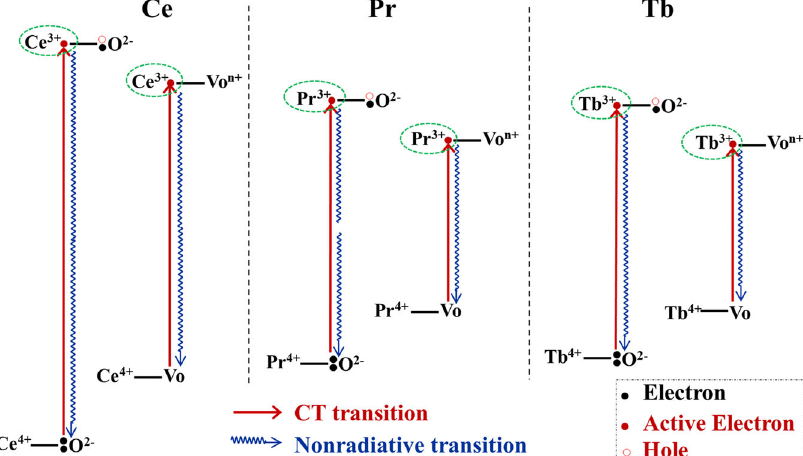
Fig. 8 The schematic diagram of charge transfer transition for Ce 4 + , Tb 4 + , and Pr 4 + . The hole in O2 p − 1 will pull the transited electron back to its original space by a nonradiative